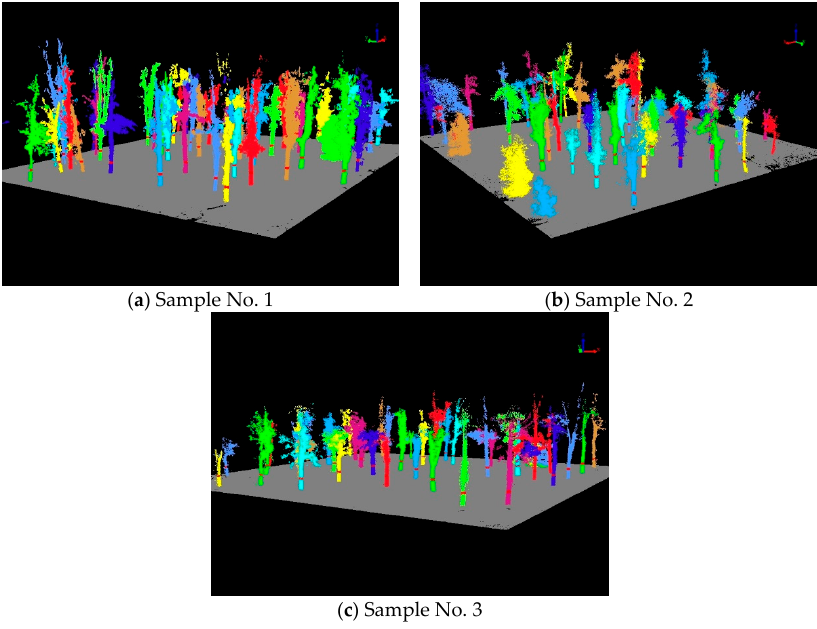
Figure 9. Batch extraction of the DBH in three test plots. ( a ), ( b ), and ( c ) show a schematic diagram of a cross-section of a point cloud in a breast height position on a point cloud model after the single-wood segmentation of samples 1, 2, and 3, respectively, where the red circle on the trunk is the breast height